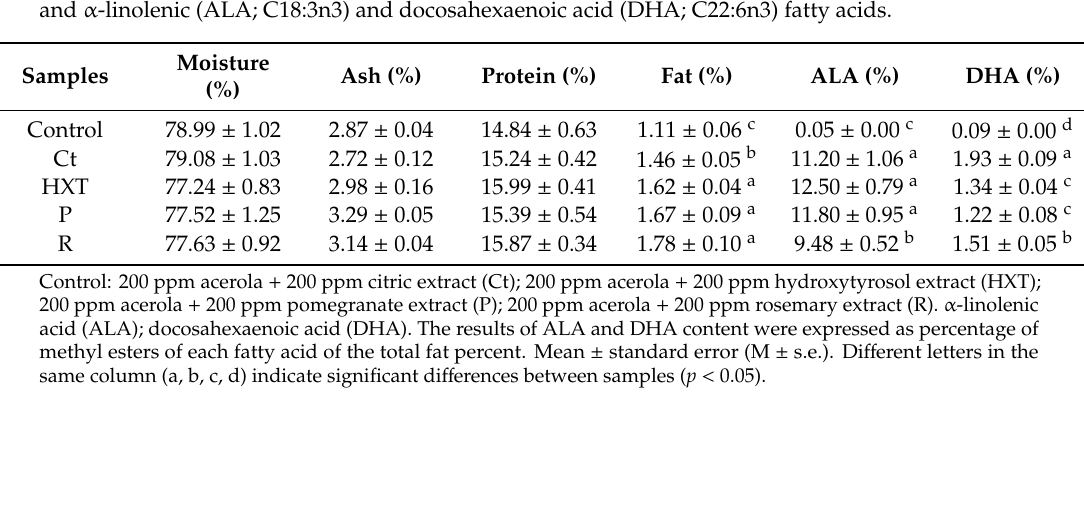
Table 1. The proximate composition (g / 100 g) of fish patty samples enriched in phenolic compounds and α -linolenic (ALA; C18:3n3) and docosahexaenoic acid (DHA; C22:6n3) fatty acids. Moisture Samples